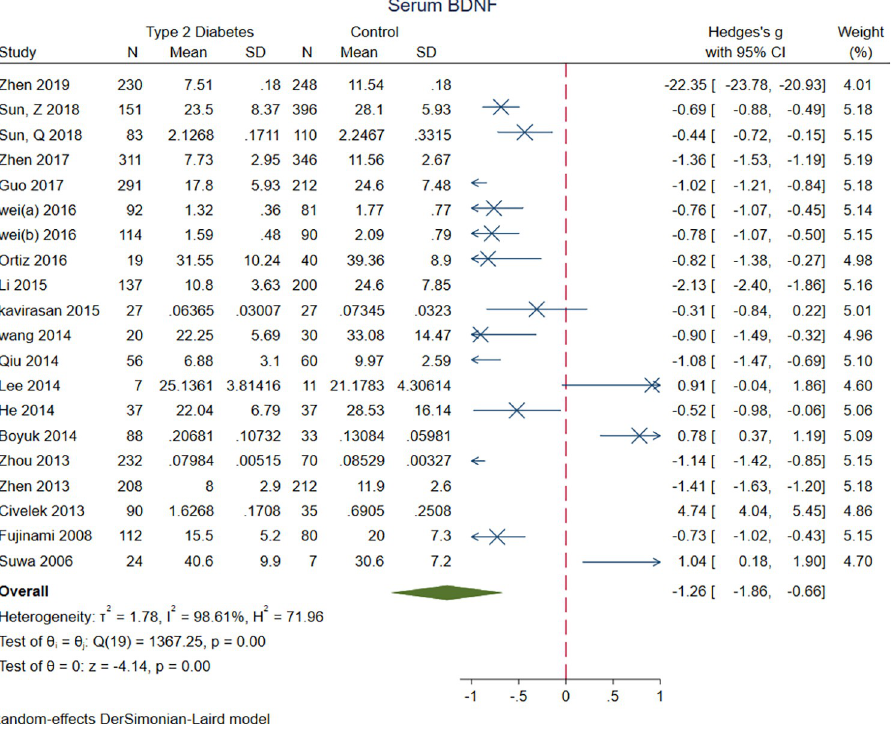
Fig 4. A meta-analysis of serum BDNF levels in patients with T2DM vs. controls.